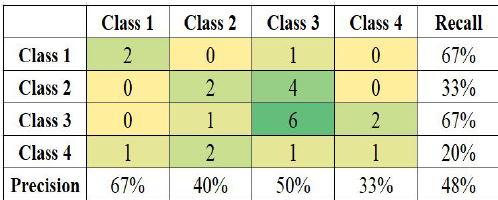
Figure 8. South Korea performed with the least accuracy of 48% among all the other classifiers. Class 1 has a moderate recall and precision value, i.e.; 67%, whereas class 4 acquired the least recall and precision values.